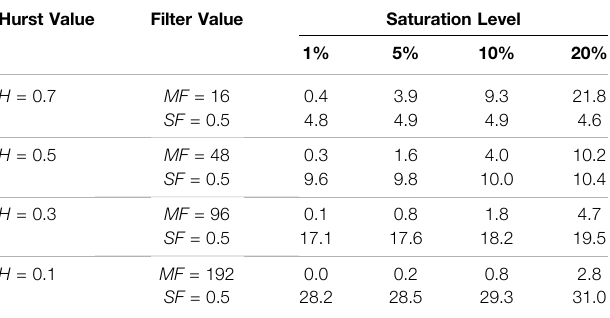
TABLE 1 | Percentages of maxima lines removed by fi ltering processes. Hurst